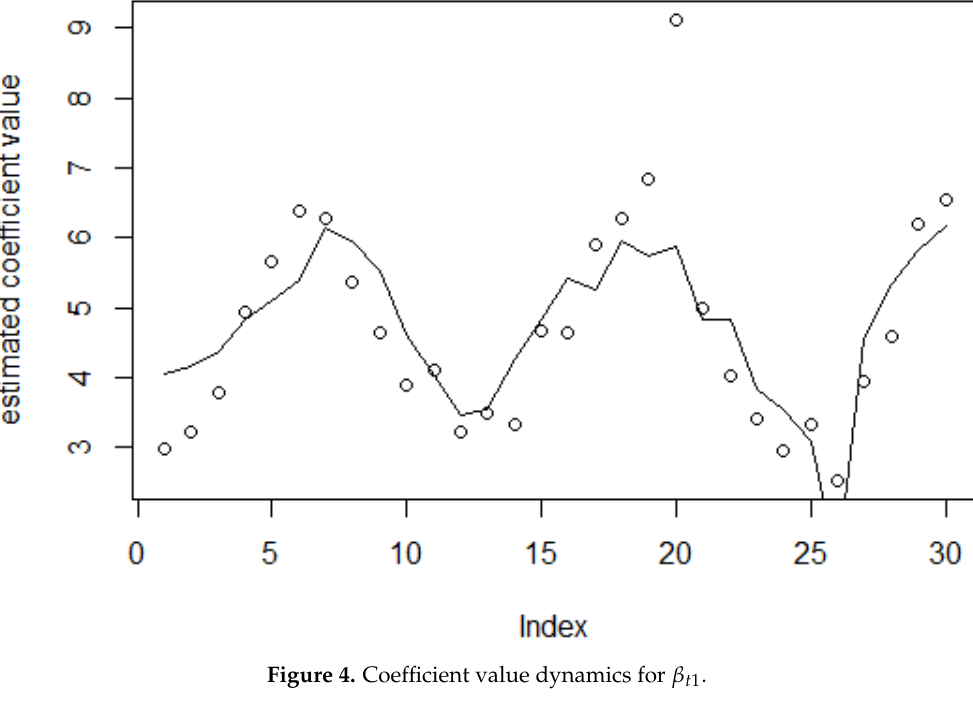
Figure 3. Coefficient value dynamics for 𝛽 𝑡0 .